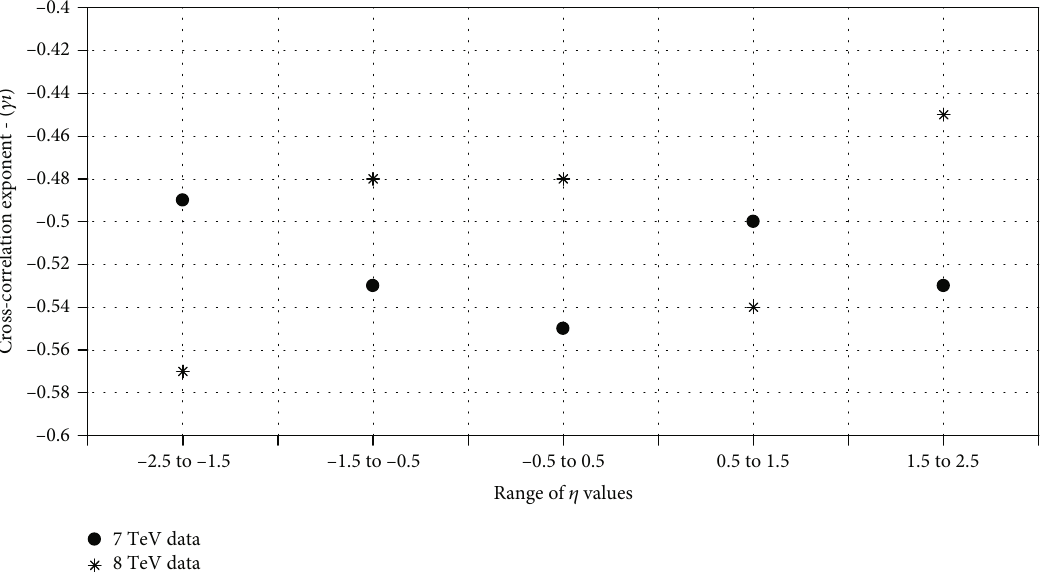
φ and η spaces for all the 5 ranges of η values for 7 and i ) between